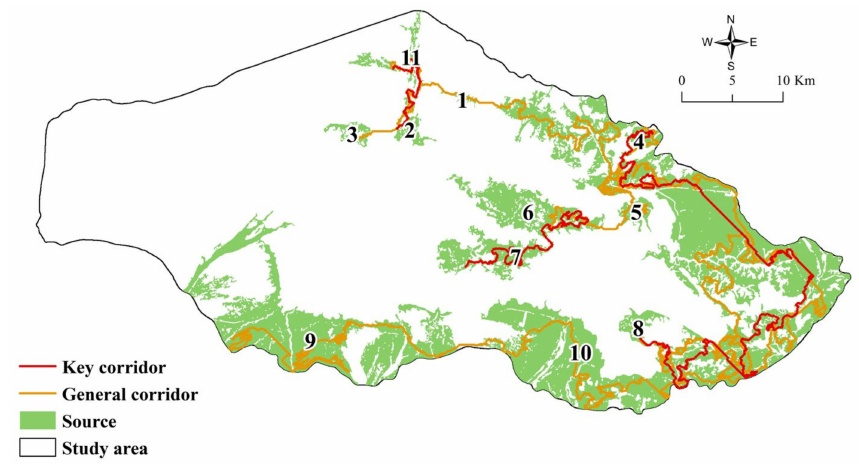
Figure 7. Distribution of ecological corridors in the study